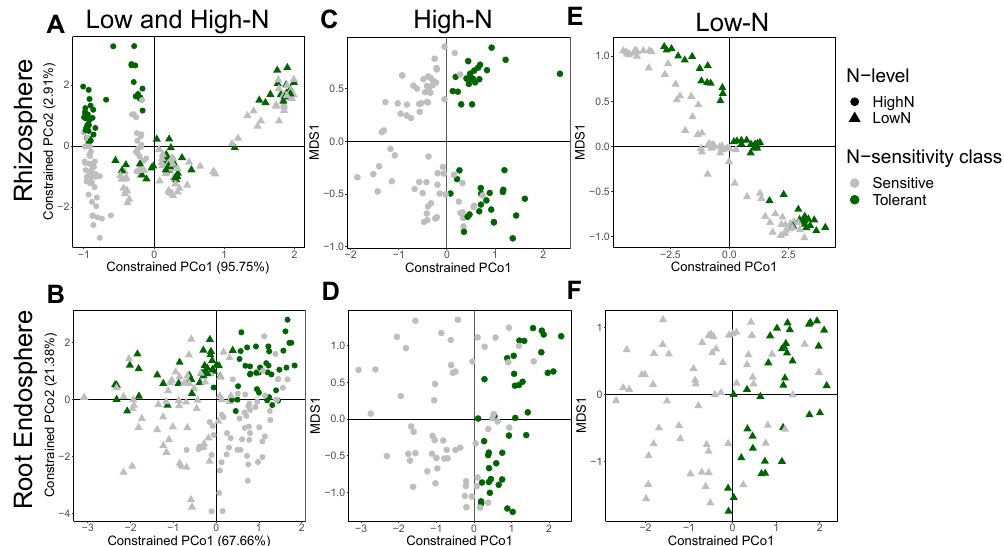
Figure 5. β -diversity differences between N-stress tolerant and sensitive genotypes. Canonical analysis of principal coordinates (CAP) based on the Bray-Curtis distance matrices considering samples from both N-levels in the ( A ) rhizosphere, and ( B ) root endosphere, as well as samples from only the high-N field in the ( C ) rhizosphere, and ( D ) root endosphere, and samples from only the low-N field in the ( E ) rhizosphere, and ( F ) root endosphere. Soil N-levels are represented with different symbols, while sorghum genotype N-stress sensitivity classes are represented with different colors.